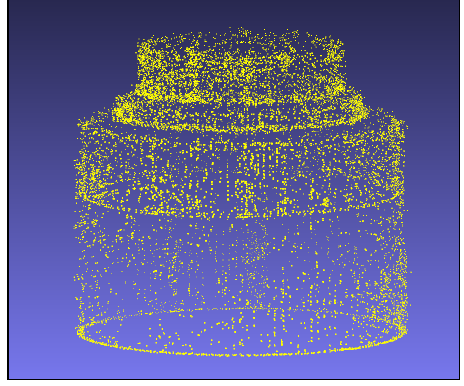
Fig. 8. Cloud Points for Cylinder Case Study.